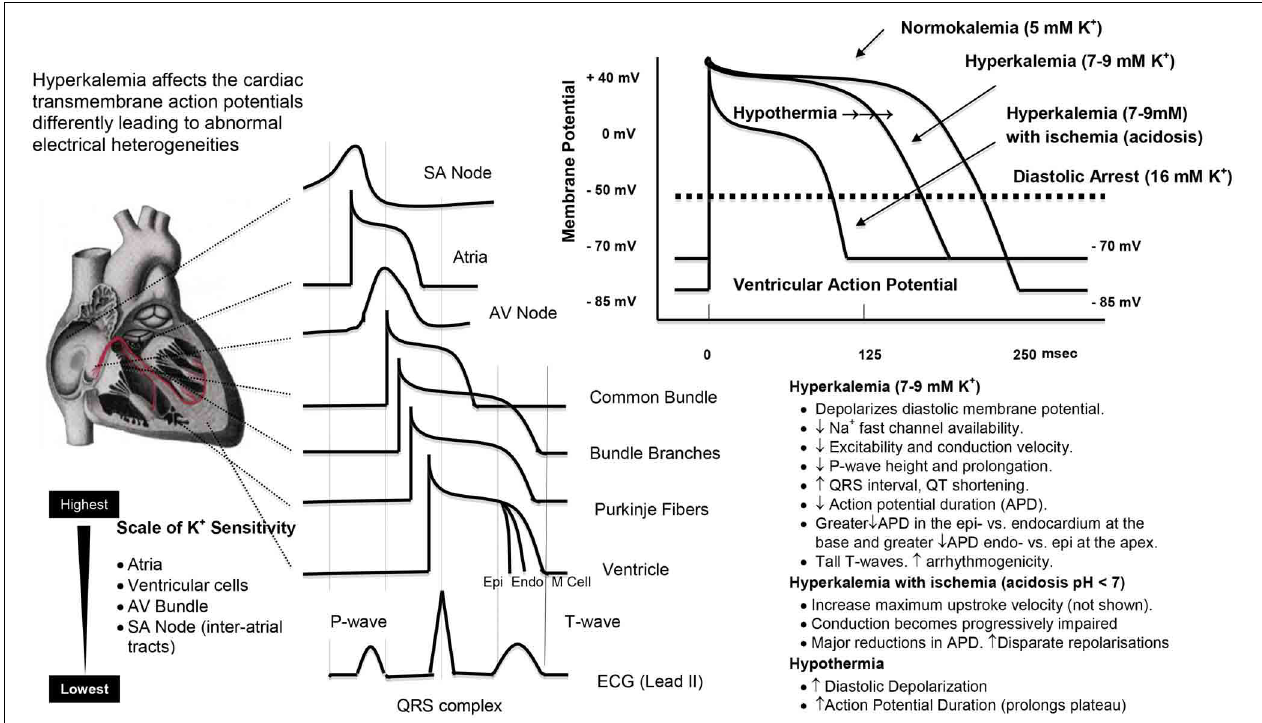
FIGURE 5 | A representation of the regional sensitivities in the heart to high potassium, and the effects of hyperkalemia, ischemia (acidosis), and hypothermia on the ventricular action potential. The effects were obtained from the empirical data in rabbit ventricle and